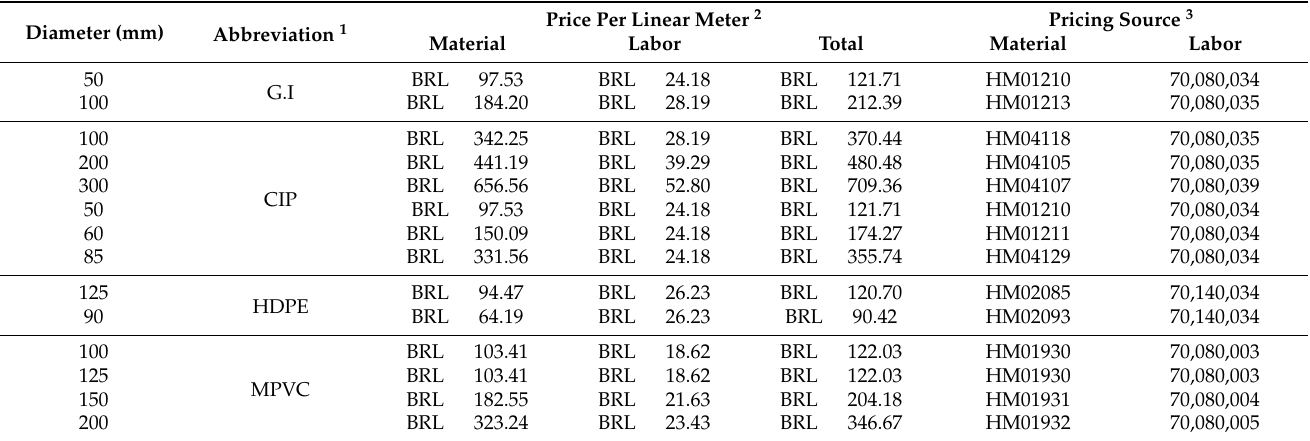
Table 4. Estimated cost of the distribution network